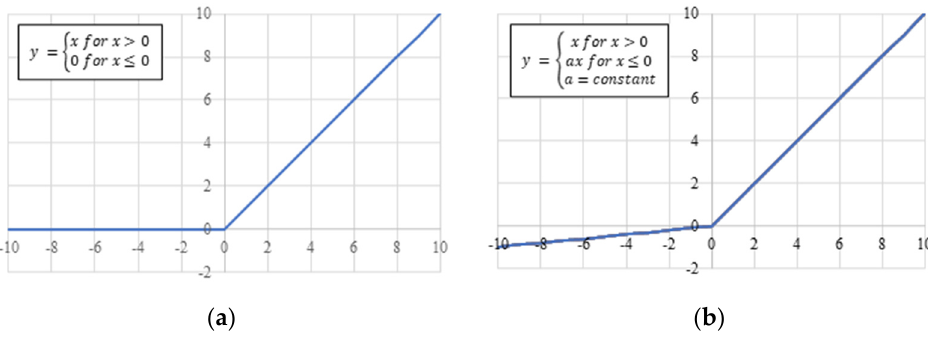
Figure 16. Non-linear activation functions, ( a ) ReLU and ( b ) Leaky ReLU.